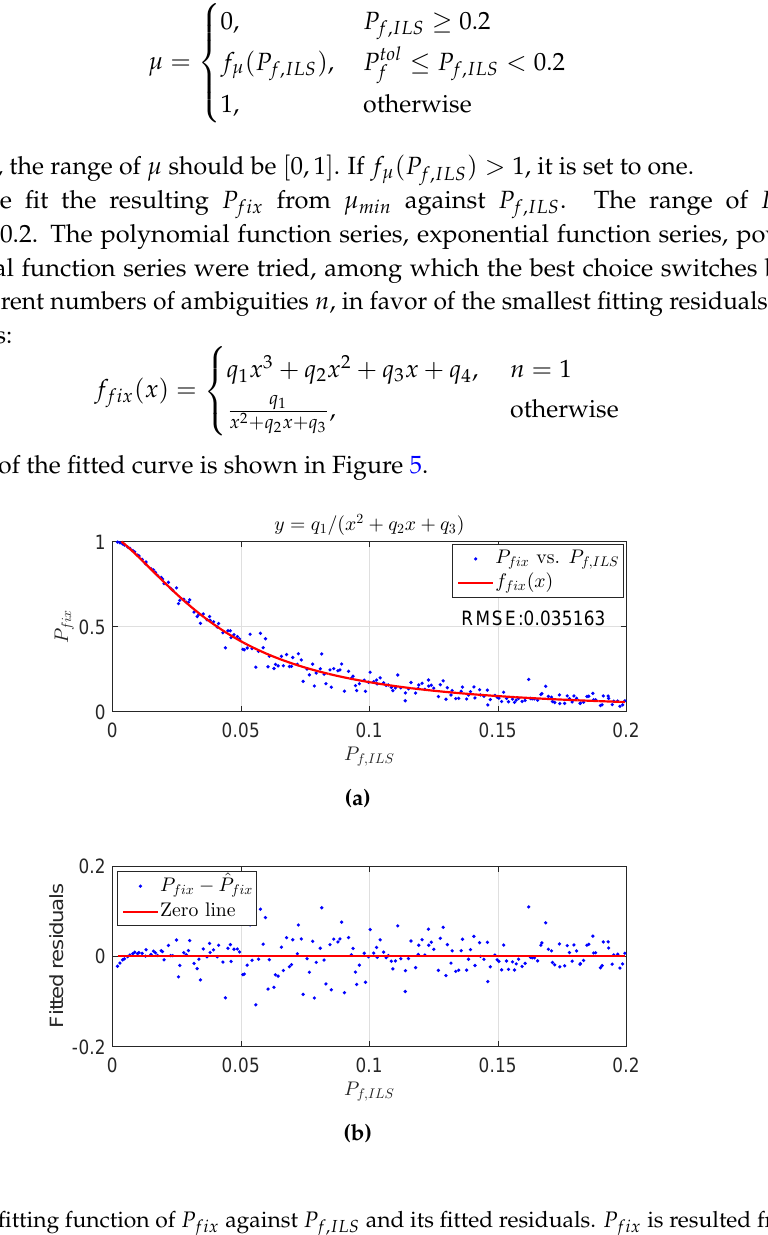
− ˆ P fix vs. P f , ILS ; ( b ) P fix fix